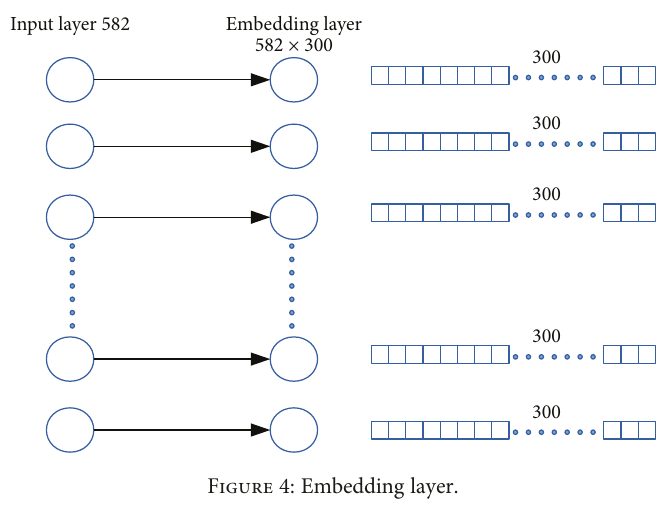
Figure 4: Embedding layer.